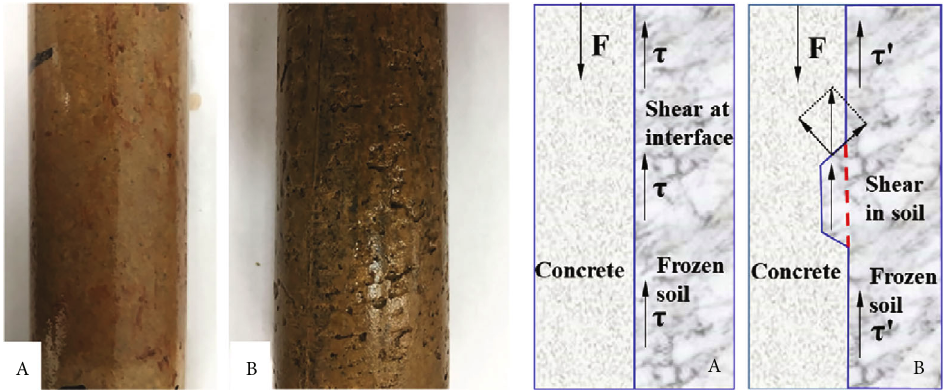
Figure 13: Piles with di ff erent roughness used in